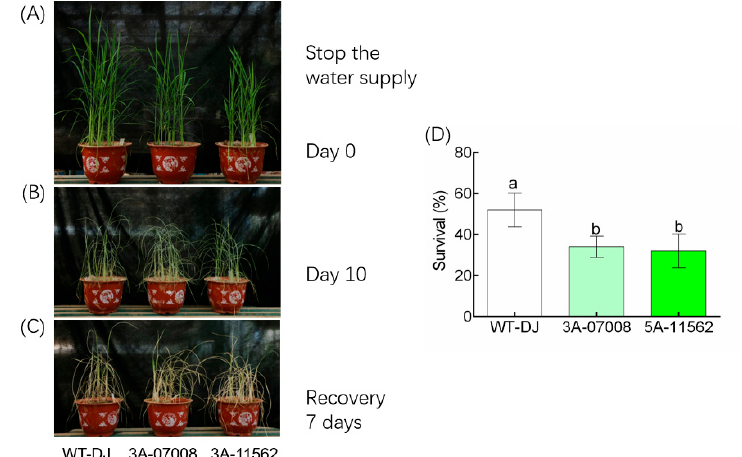
Figure 7. Drought stress sensitivity of OsTBP2.2 transgenic lines at the seedling stage. ( A ) The seedlings of ostbp2.2 and WT-DJ were cultivated for 3 weeks by full irrigation in soil, then water supply was withheld for ten days. ( B ) Phenotype of stop water supply ten days. ( C ) Phenotype of the seedlings one week after re-watering. ( D ) Seedling survival of ostbp2.2 and WT-DJ after re-watering. Error bars: SE ( n = 5). Significant differences between ostbp2.2 and WT-DJ are indicated by different letters. ( p < 0.05).